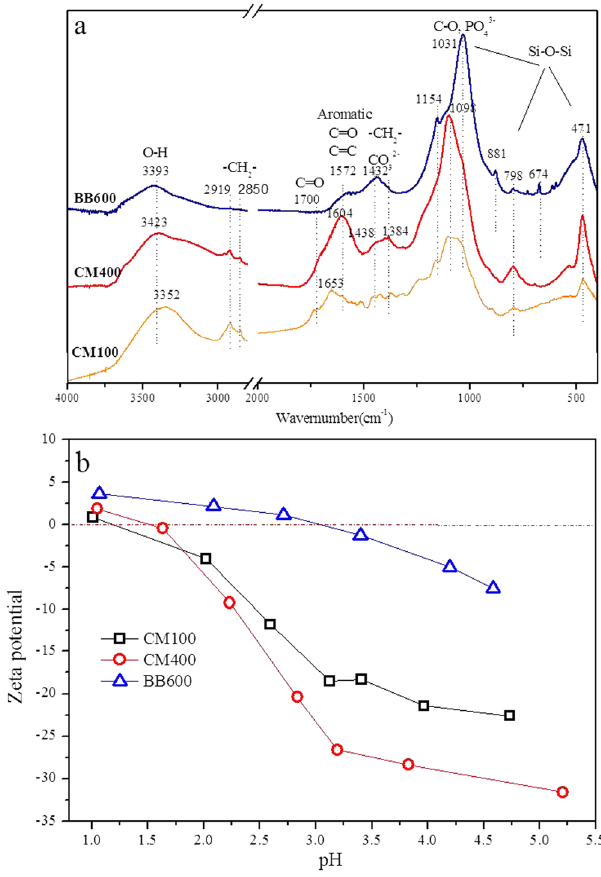
Figure 2. FTIR spectra ( a ) and ζ -Potential ( b ) of the cattle manure biochar (CM100 and CM400) and bamboo biochar (BB600). The numbers in the sample names represent the pyrolysis